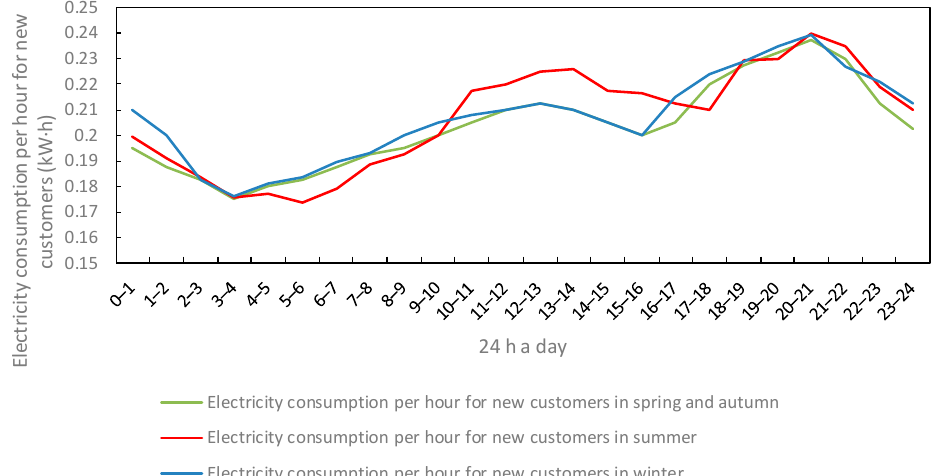
Figure 9. Change in electricity consumption of new load users.